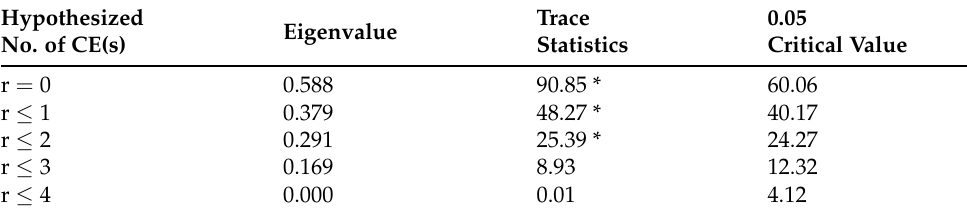
Table A4. The Johansen results. Trace test indicates 3 cointegrating eqn(s) at the 0.05 level; * denotes rejection of the hypothesis at the 0.05